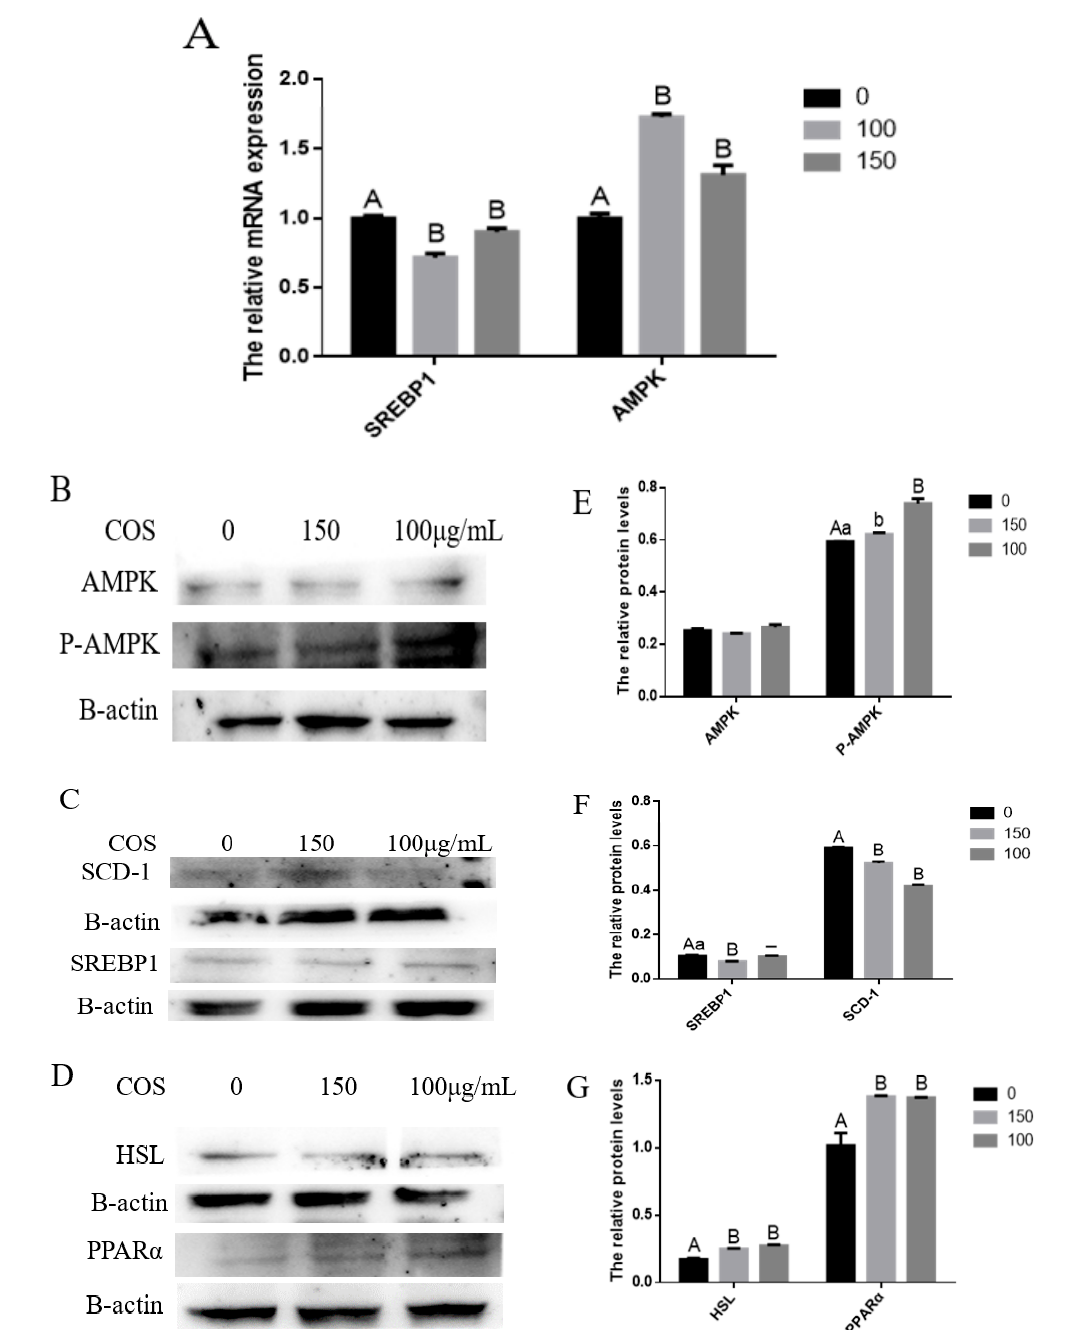
Figure 3. Chitosan oligosaccharide (COS) inhibits milk fat synthesis in bovine mammary epithelial cells (BMECs) via the AMP-activated protein kinase ( AMPK ) signaling pathway. BMECs were treated with different concentrations of COS (0, 100, 150 µ g/mL) for 24 h. ( A ) Relative mRNA expression of SREBP1 and AMPK in BMECs treated with COS. A greyscale scan quantified the relative folds of AMPK and its downstream genes protein levels from the western blots. AMPK and p-AMPK ( B ); HSL and PPAR α ( C ); SREBP1 and SCD1 ( D ) protein levels were detected by Western blotting. Relative protein expression levels of AMPK , p-AMPK , HSL , PPAR α , SREBP1 and SCD1 compared to that of β -actin ( E – G ). Data were the mean ± SE from three independent experiments. Different small letters showed significant difference ( p < 0.05), different capital letters showed extremely significant difference ( p < 0.01), and the same letters or unmarked letters had no significant